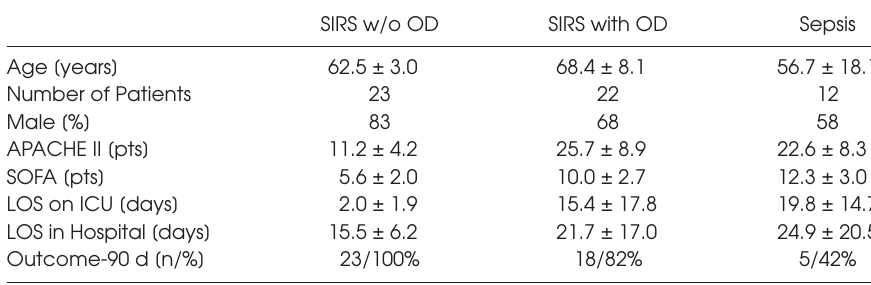
Table 1. Characteristics of patients with systemic inflammatory response syndrome after major surgery, that is, cardiac surgery, due to multiple organ failure and due to severe